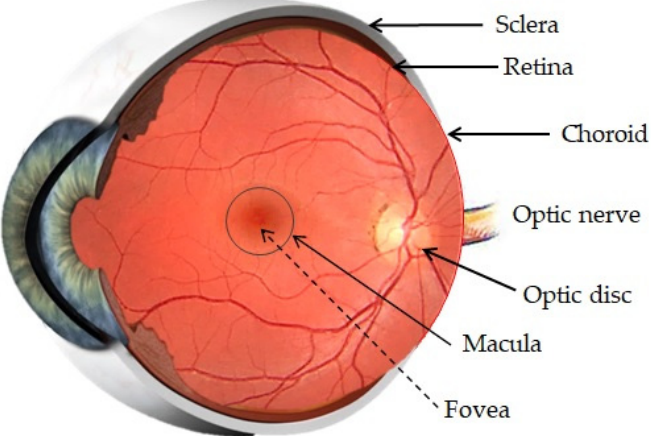
Figure 2. Anatomy of the posterior segment of the eye. Adapted from [24,25] Akbar, S., 2017 and Bharali, P., 2015.